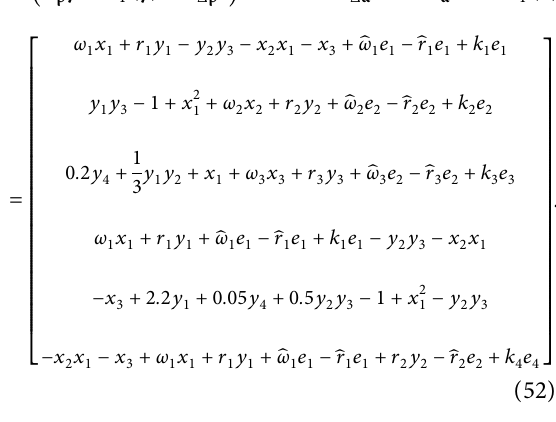
,x ) space; (d) projection in ( x 1 3